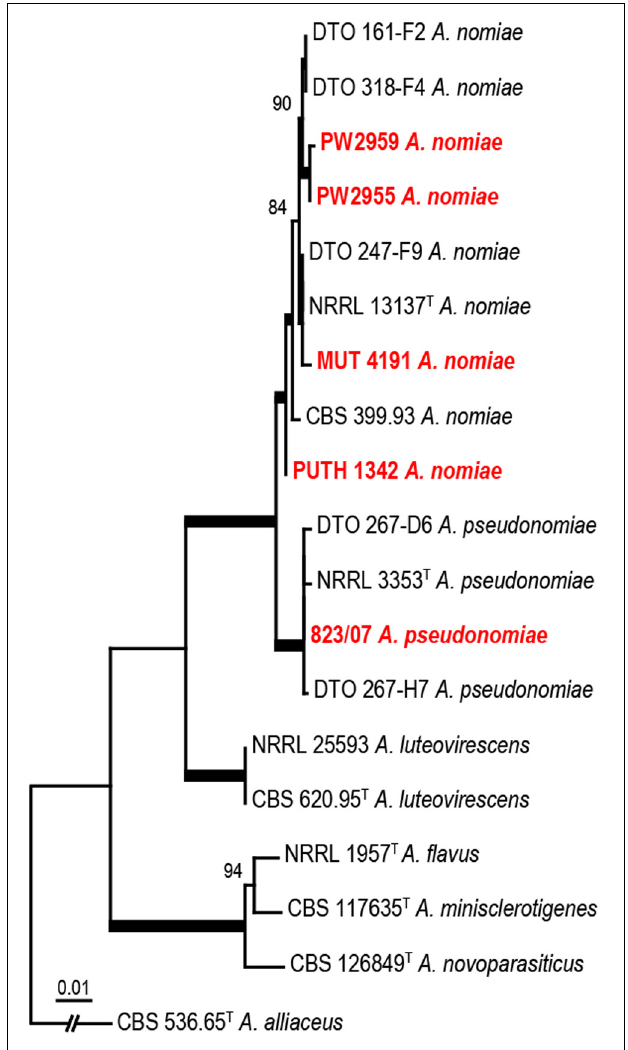
FIGURE 5 | Phylogenetic analysis of three concatenated genomic regions (ITS, BenA, and CaM ) involving PUTH 1342, seven reference strains, and closely related species from section Flavi . A. alliaceus were used as outgroup. The A. nomiae and A. pseudonomiae isolates in red were previously isolated from clinical specimens. The phylogram was constructed by the maximum likelihood method with 1000 bootstrap